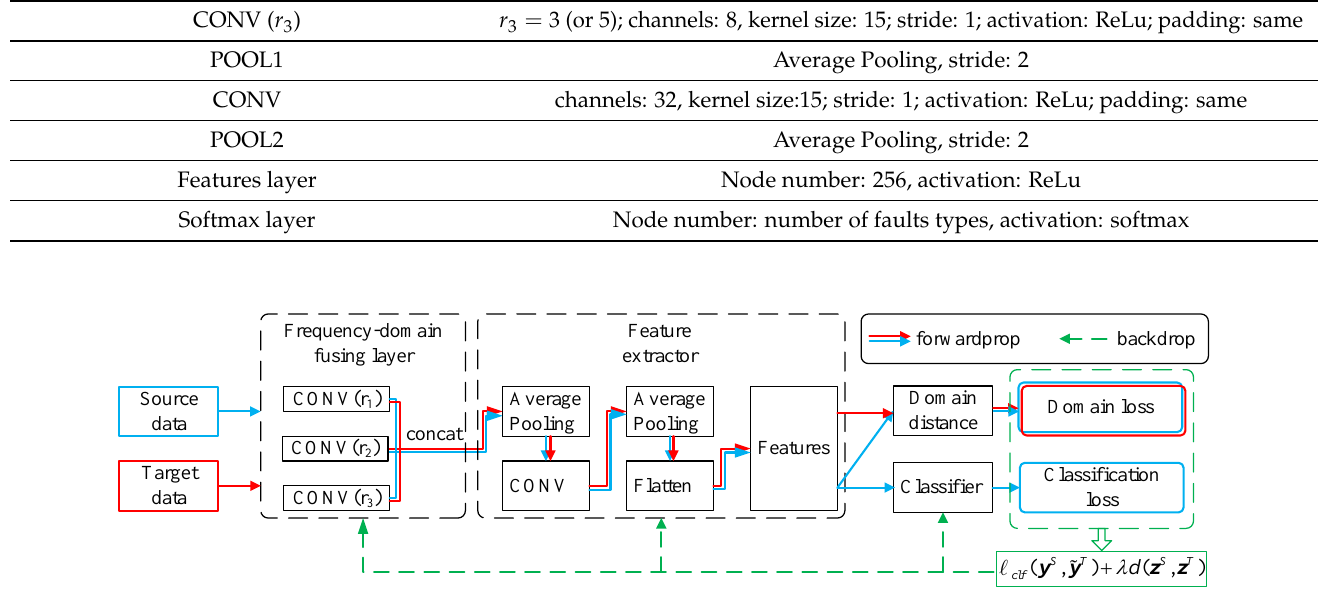
Figure 4. Architecture of proposed